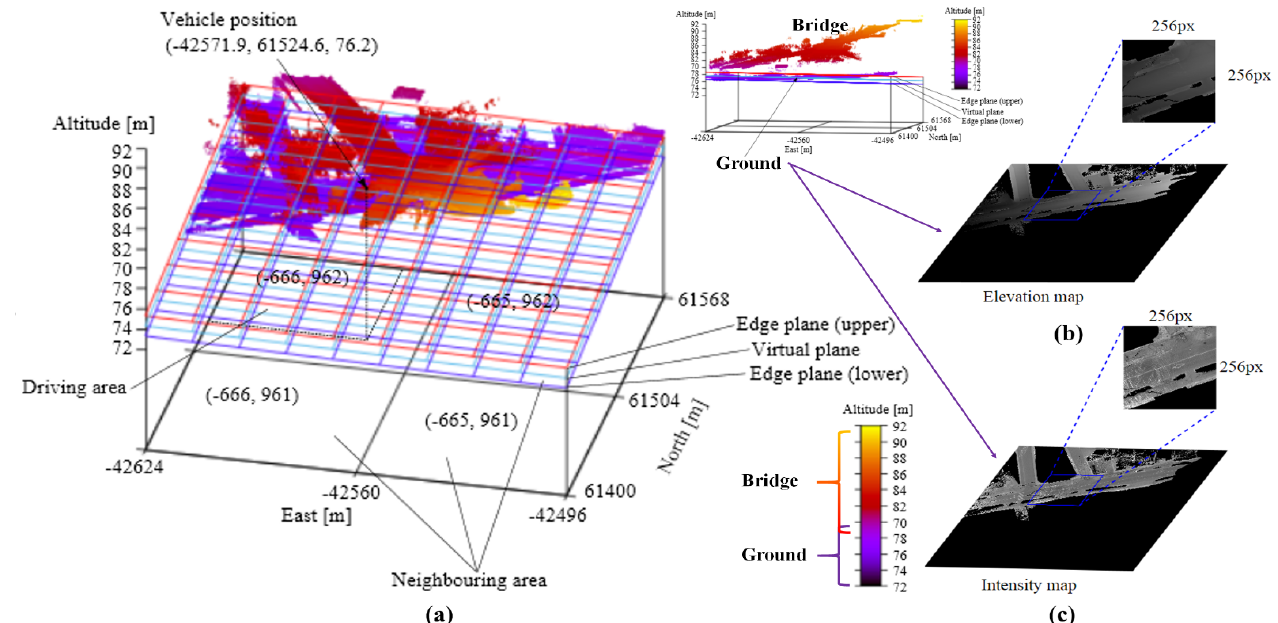
Figure 5. Map retrieval strategy. ( a ) Restoring four sub-images of the ground layer in Figure 3 based on the vehicle pose and creating lower and upper virtual planes. ( b ) Elevation map image created by merging the lower two layered elevation images in Figure 4a. ( c ) Intensity map image of the ground road surface.